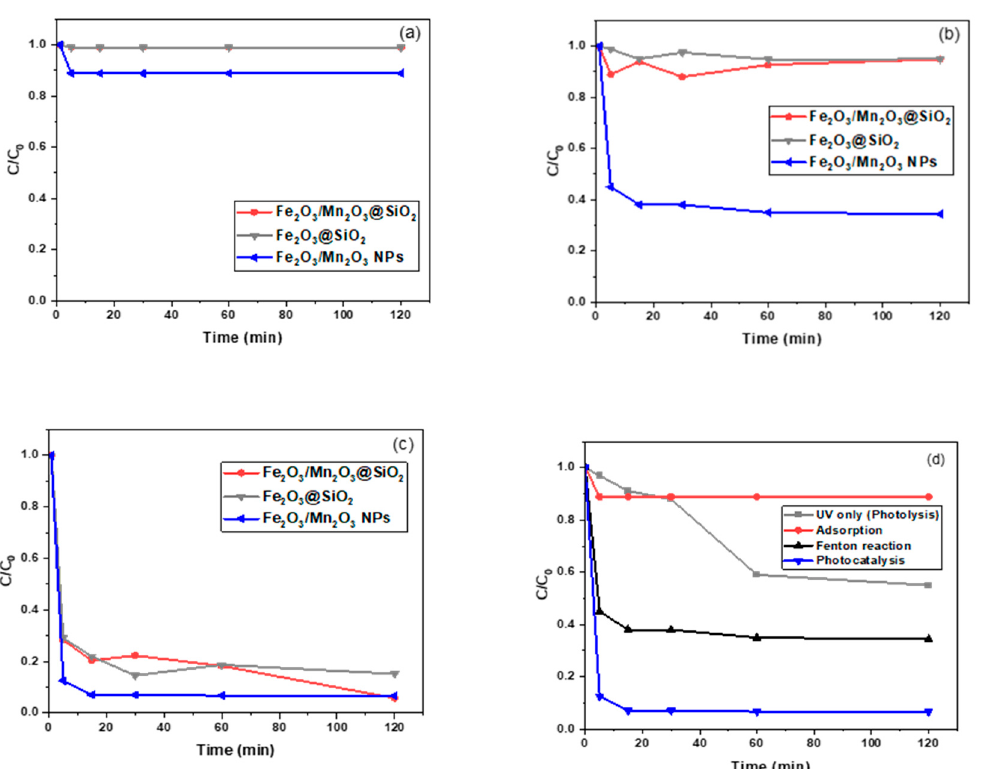
Figure 9. Degradation of Congo red (CR) with Fe 2 O 3 /Mn 2 O 3 nanoparticles (FM-NPs), Fe 2 O 3 /Mn 2 O 3 @SiO 2 (FMS) under different conditions; ( a ) Only adsorption (without UV + H 2 O 2 ), ( b ) Fenton reaction with H 2 O 2 (without UV), and ( c ) Photo-Fenton reaction with UV + H 2 O 2 (reaction conditions: catalyst dose = 1 g/L, initial concentration of CR = 10 mg/L, initial pH = 7), and ( d ) comparison of degradation performance with FM-NPs under different reaction conditions.